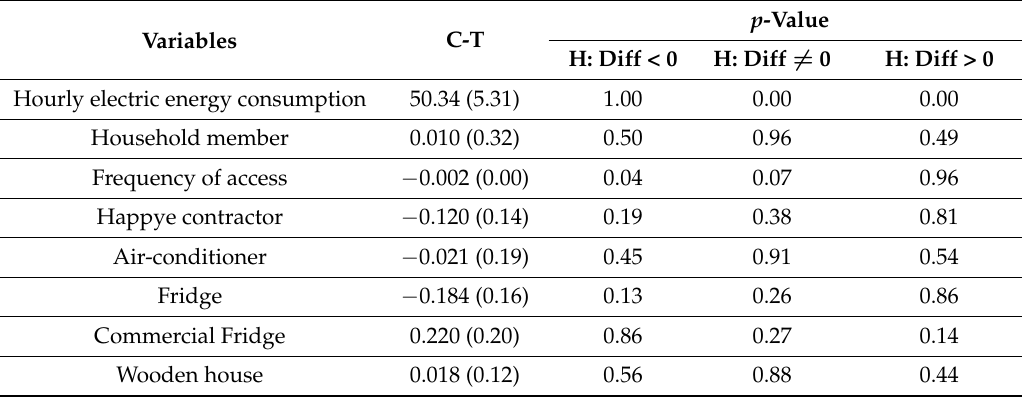
Table 2. Differences between the two groups. Standard errors in